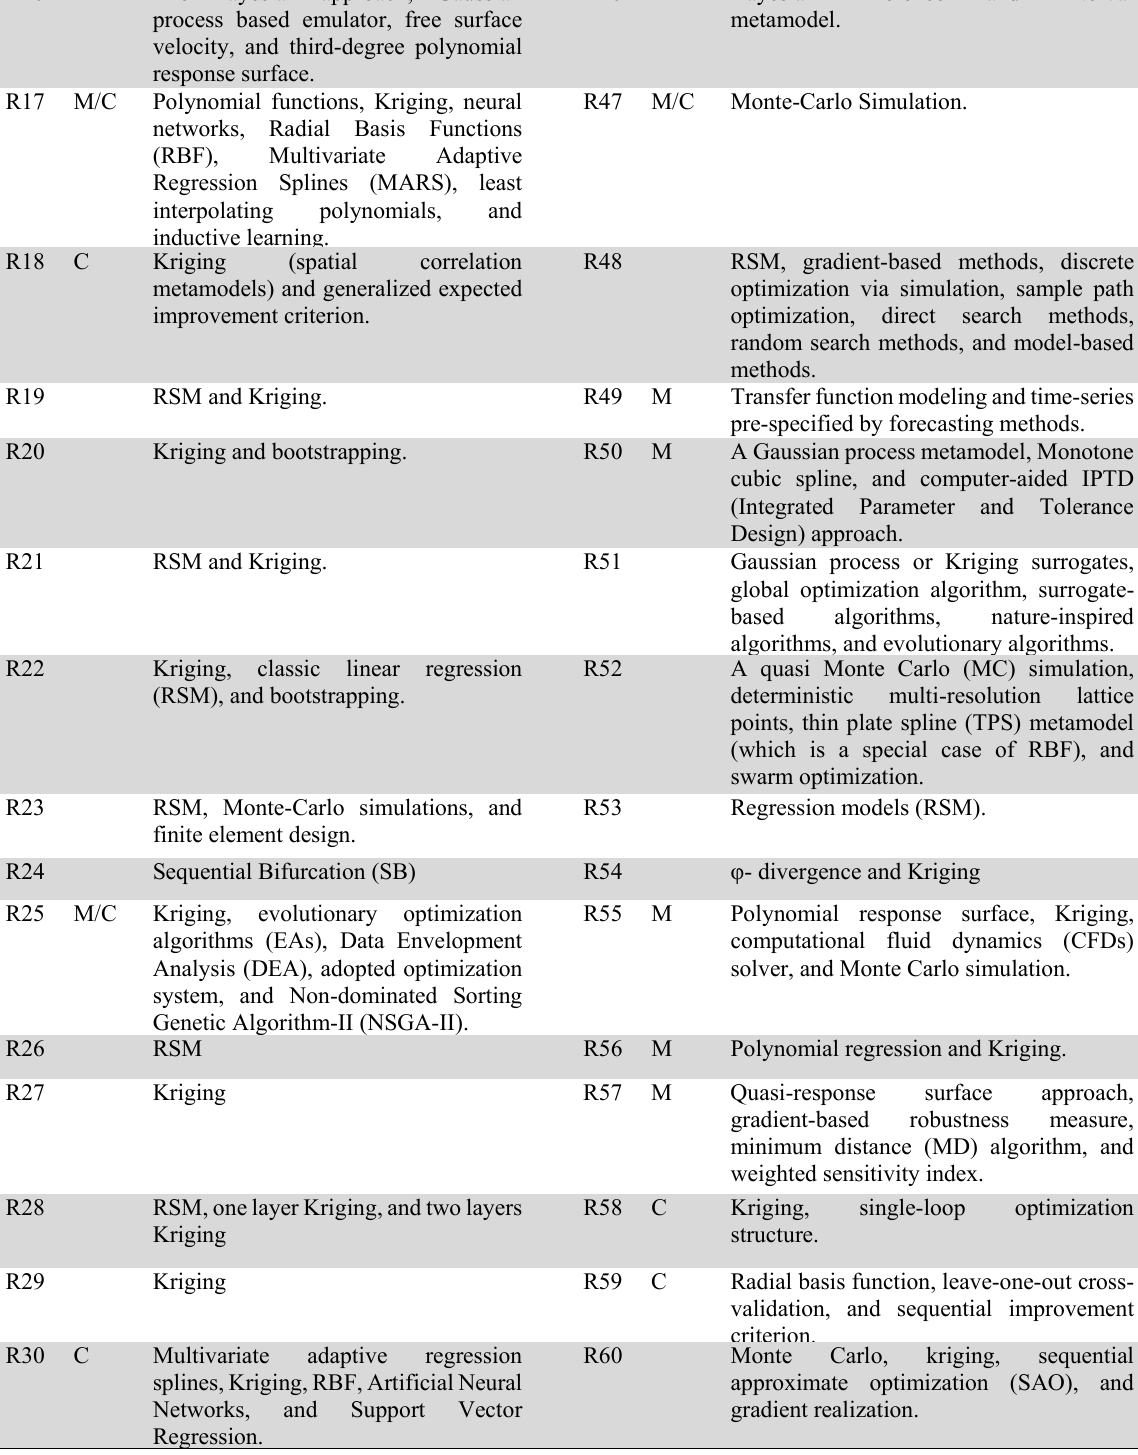
Table 9 Simulation optimization methods applied in literature (“M” means multi-objective, “C” means constrained problem)